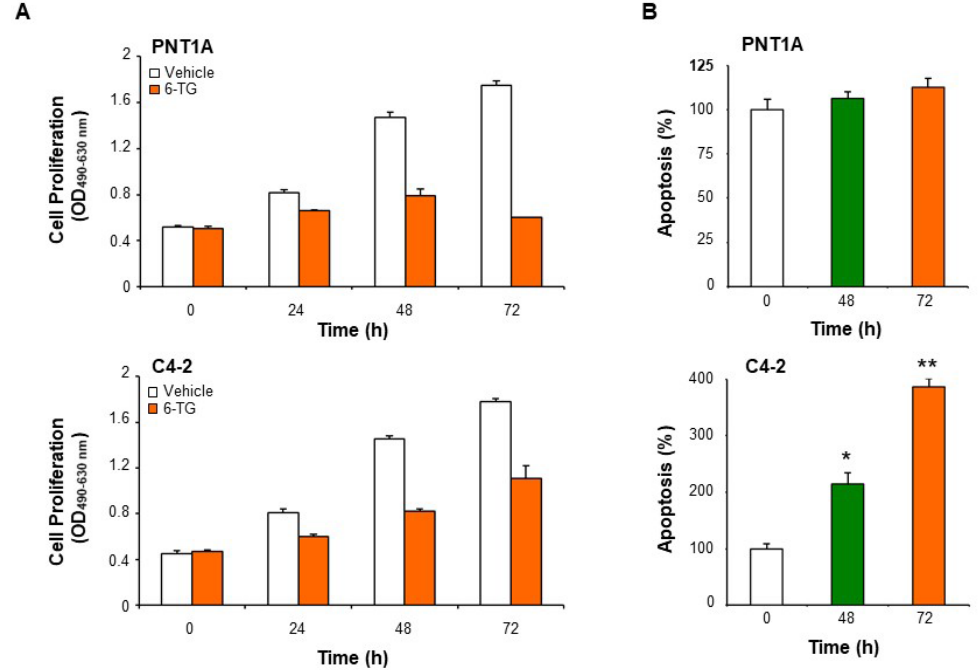
Figure 4. 6-TG-mediated inhibition of cell proliferation is time-dependent. ( A , B ) PNT1A and C4-2 cells were treated with 5 µ M 6-TG up to 72 h, and cell proliferation and apoptosis were measured by XTT ( A ) and Cell Death Detection ( B ) assay, respectively. Each point represents the mean ± SD from cells of triplicate wells. The experiment was repeated two times. * p < 0.001; ** p < 0.0001.